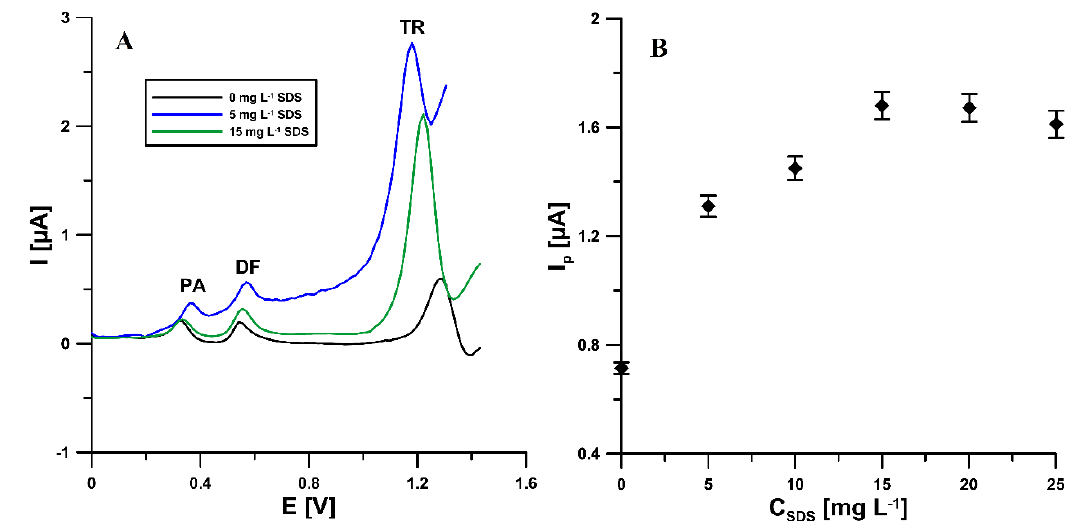
Figure 2. ( A ) Voltammograms of 2 × 10 −6 mol L −1 PA, 1 × 10 −7 mol L −1 DF, and 5.0 × 10 −6 mol L −1 TR in 0.1 mol L −1 CH 3 COOH/CH 3 COONa buffer of pH 4.0 ± 0.1 containing 0, 5, and 15 mg L −1 SDS. ( B ) Influence the SDS concentration on voltammetric response of 5.0 × 10 −6 mol L −1 TR. The DPAdSV parameters as in Figure 1A.